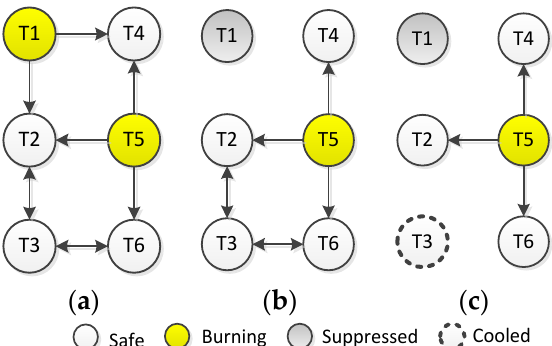
Figure 7. Non-optimal firefighting strategy for Scenario 3. ( a ) T1 and T5 are on fire. ( b ) T1 has been suppressed while T5 is on fire. ( c ) T1 has been suppressed, T5 is on fire, and T3 is cooled. Table 3. Tanks’ and terminal’s o ut-closeness scores for the graphs in Figures 6 and 7.